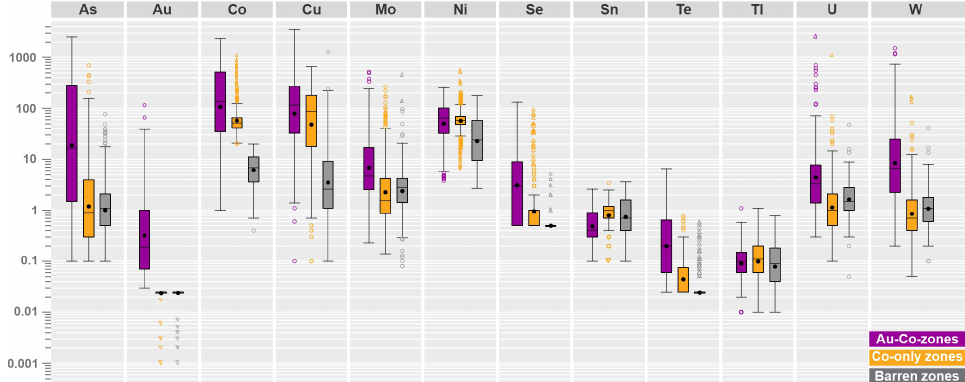
Figure 8. Logarithmic-scaled boxplot illustrating the range in concentration of metals and pathfinder elements in Co-only zones, Au–Co zones and barren zones.